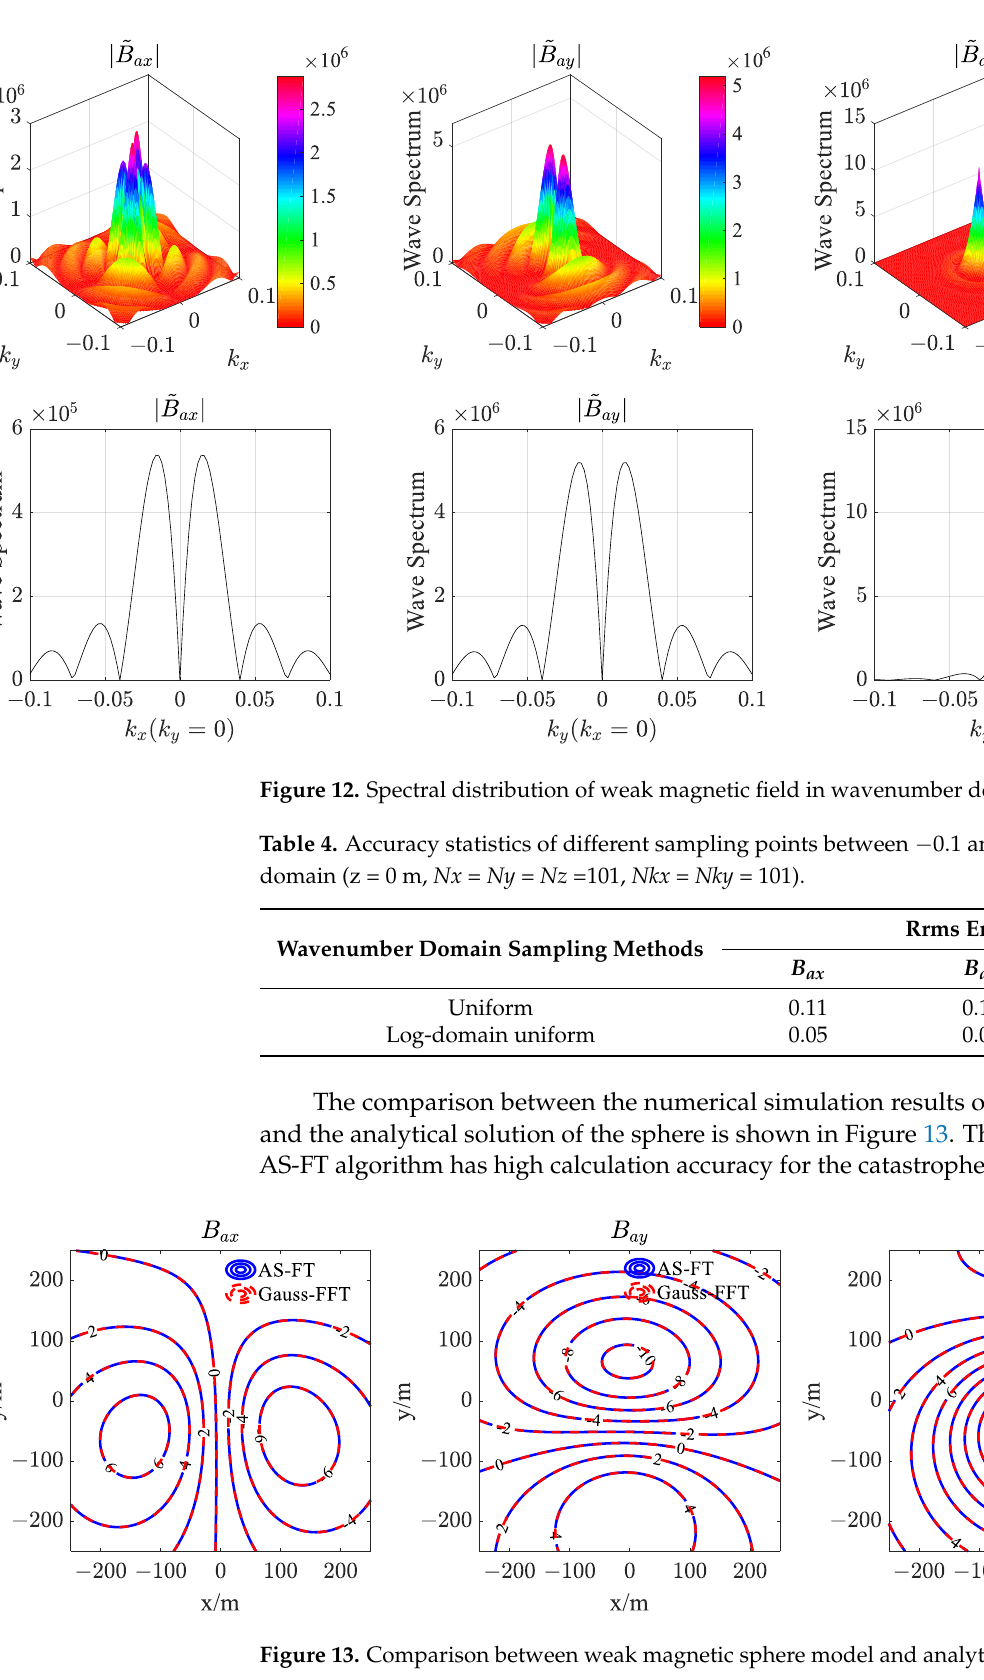
Figure 11. Spectrum distribution of weak magnetic field at different depths. The horizontal ordinate of figures ( a , c , e ) is non-logarithmic, and the horizontal ordinate of figures ( b , d , f ) is logarithmic.